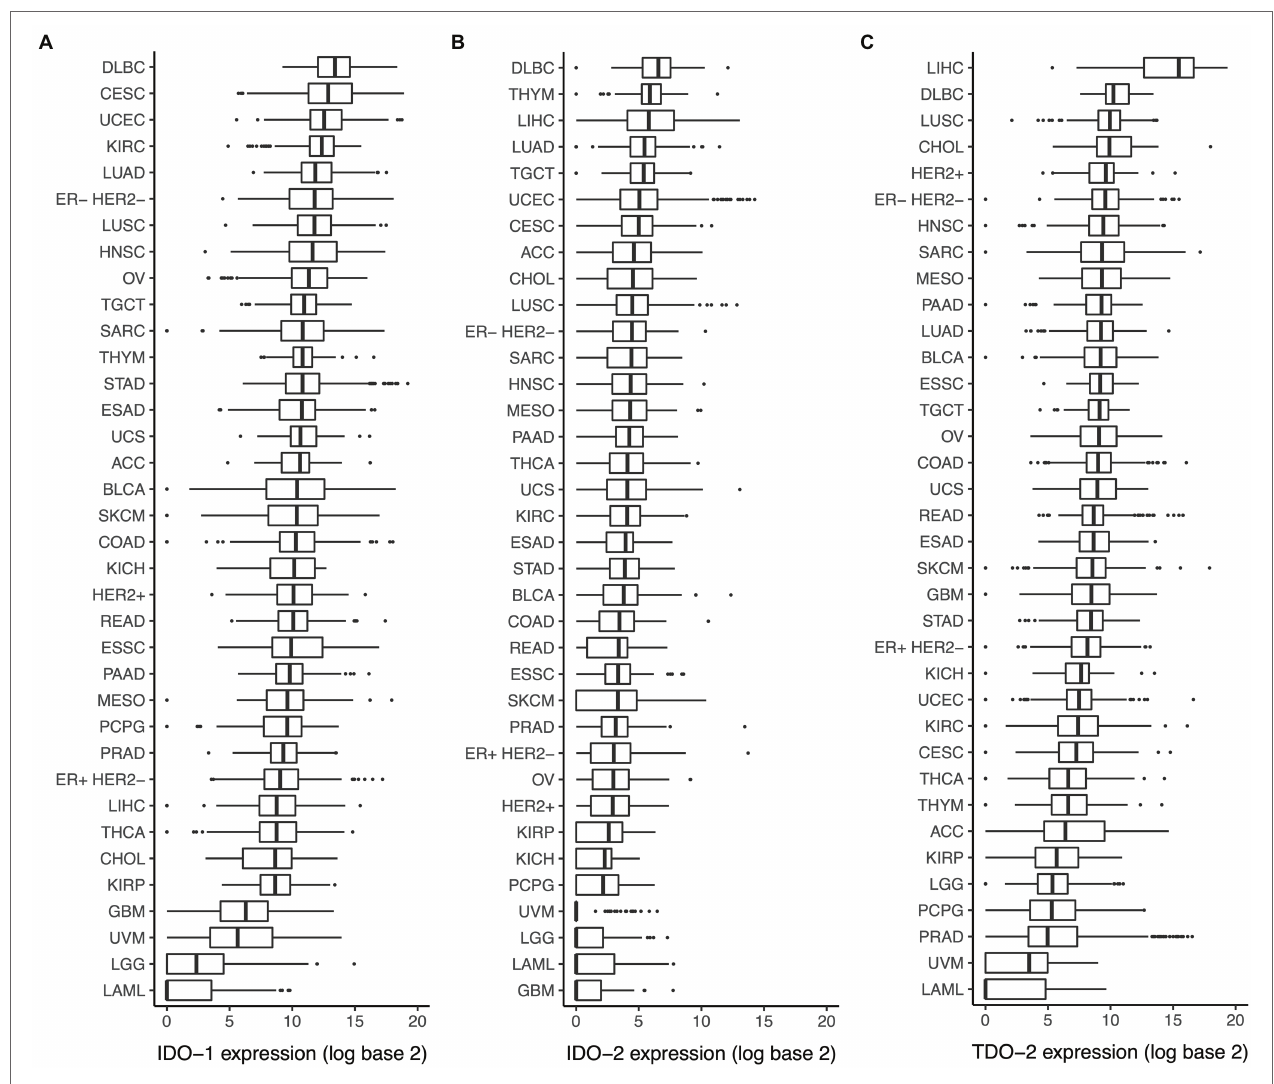
FIGURE 1 | Expression of indoleamine 2,3-dioxygenase (IDO) pathway genes in various cancer types. Expression of (A) IDO-1 , (B) IDO-2 , and (C) TDO-2 in various cancer types. Cancer type acronyms are standard the Cancer Genome Atlas (TCGA) abbreviations (https://gdc.cancer.gov/resources-tcga-users/tcga- code-tables/tcga-study-abbreviations). ESAD, esophageal adenocarcinoma; ESSC, esophageal squamous cell